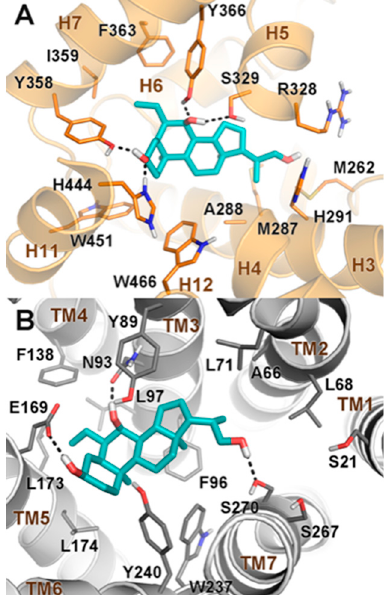
Figure 3. ( A ) Docking pose of compound 3 in the crystal structure of FXR and ( B ) in the homology model of GPBAR1. The ligand is depicted as cyan sticks. FXR and GPBAR1 are shown as orange and grey cartoons, respectively. Amino acids important for ligand binding are depicted as sticks. Non-polar hydrogens are omitted for clarity. Hydrogen bonds are shown as dashed black lines.